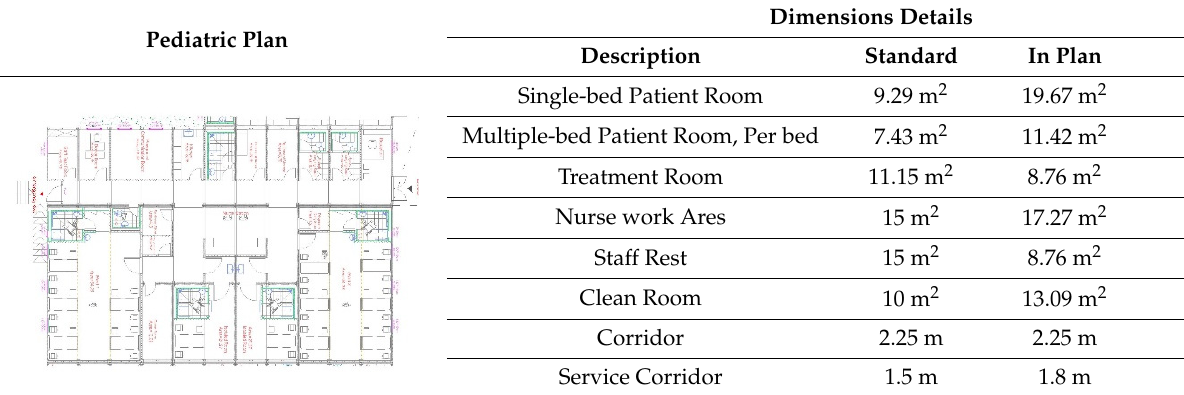
Table 4. Dimensional requirements of the pediatric department compared to standards.